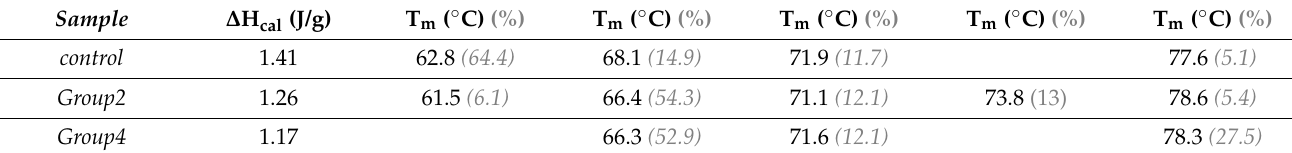
Table 3. Contribution of deconvolved transitions from Figure 2 to the total enthalpy change, gray numbers represent the relative participation to the total change (based on instrument error, only those compounds are used which have a higher than 5% change, recently